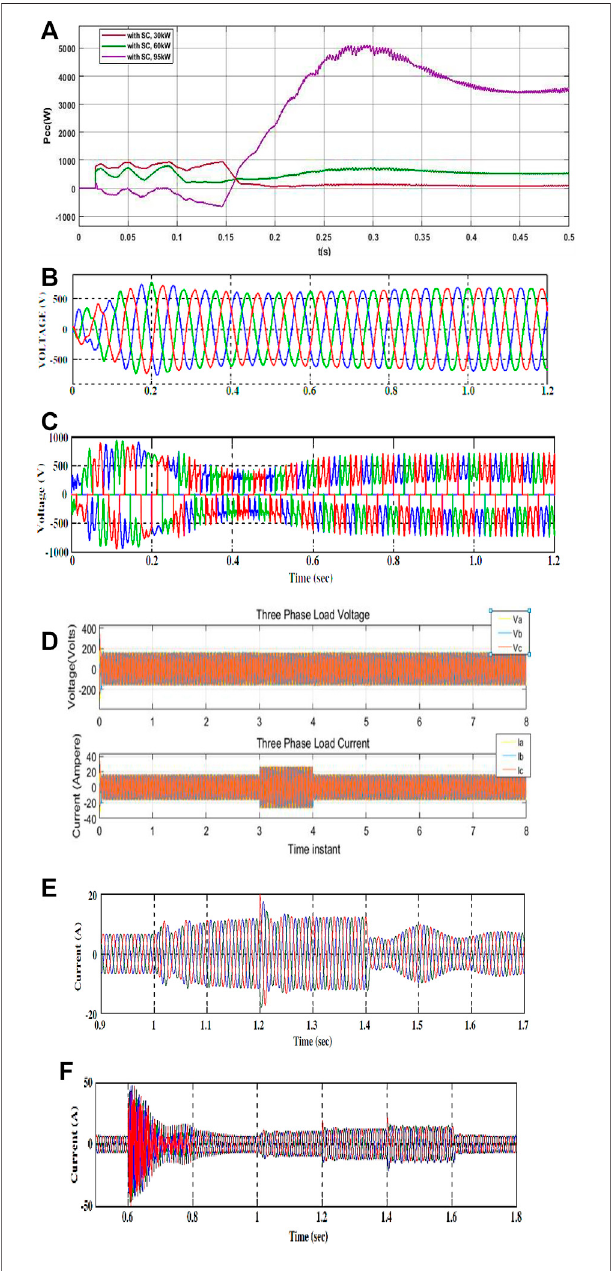
FIGURE14|(A) Comparativedynamicstabilityperformanceofthedifferent rating SC to the effectively stored energy into the distributed grid. (B) Solar PV moduleviaDC-to-ACinverterduringno-loadscenario. (C) Vcharacteristicsofwind energy subsystem. (D) Measured three phase V and I waveforms under no load. (E) Current stability response of HPGS under RL load. (F) Current stability response of the HPGS with SC operation under RL load.